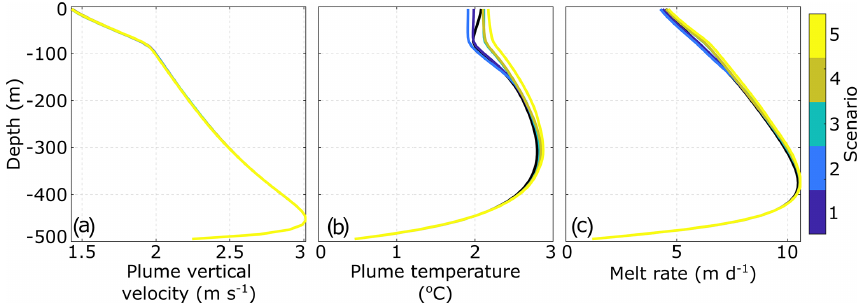
Figure 9. Plume dynamics for iceberg scenarios 1–5. (a) Plume vertical velocity. (b) Plume temperature. (c) Glacier submarine melt rate in the plume. All simulations are based on BCstandard boundary conditions and 500ms − 1 subglacial